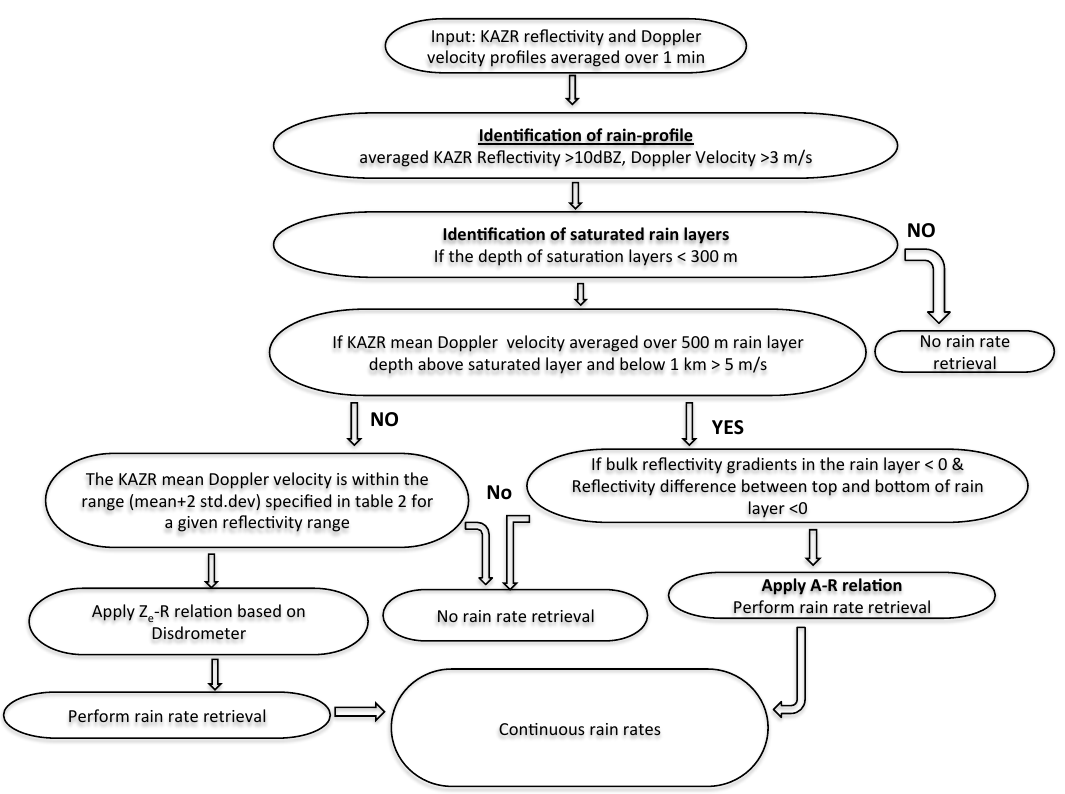
Figure 3. Flowchart of sequential steps for retrieving rain rates from the KAZR observations (reflectivity and Doppler velocity). The rain layers selected for the retrievals are below 1km above the ground level for all the